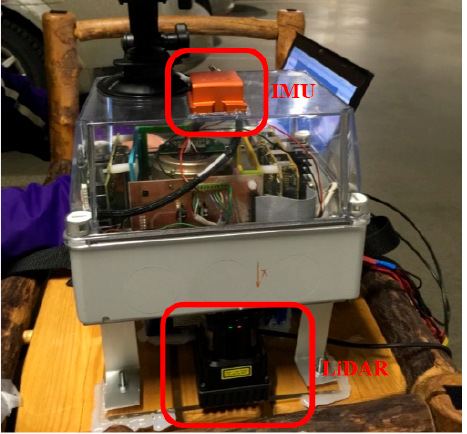
Figure 5. System hardware platform.